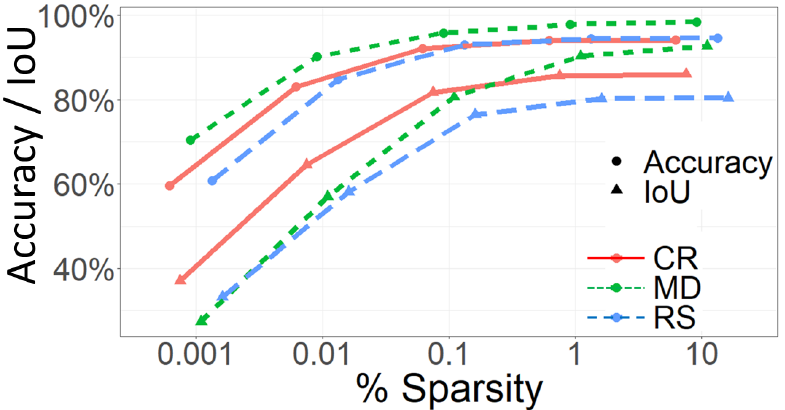
Figure 7. Augmentation experiment at different sparsities. Accuracy (circles) and Mean Intersection over Union (IoU) (triangles) are represented by shapes. CR, MD, and RS are in red, green and blue. The increase in accuracy and IoU is very low above 0.1%